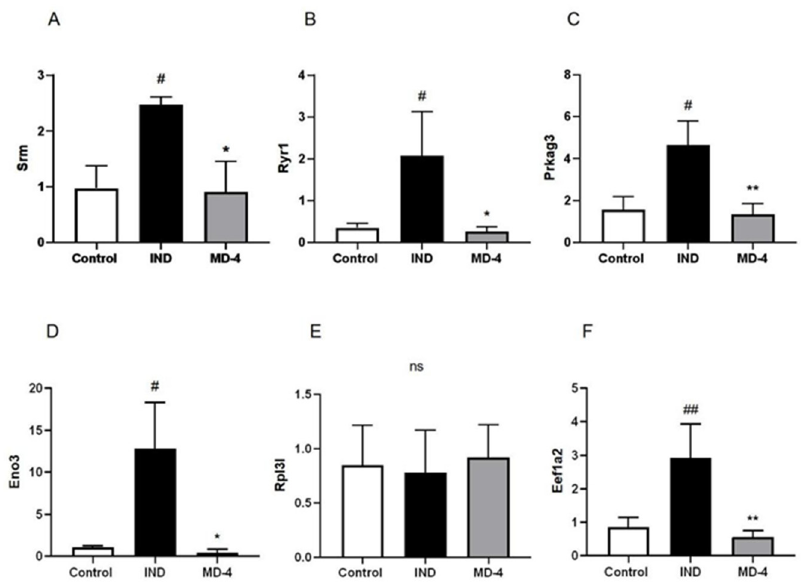
Figure 4. Relative expression of Srm , Ryr1 , Prkag3 , Eno3 , Rpl3l and Eef1a2 determined by qRT-PCR. β -actin was selected as an internal control. Values represent means ± standard error mean ( n = 6). # p < 0.05 vs. control, ##: p < 0.01 vs. control. * p < 0.05 vs. IND-treated, ** p < 0.01 vs. IND-treated.